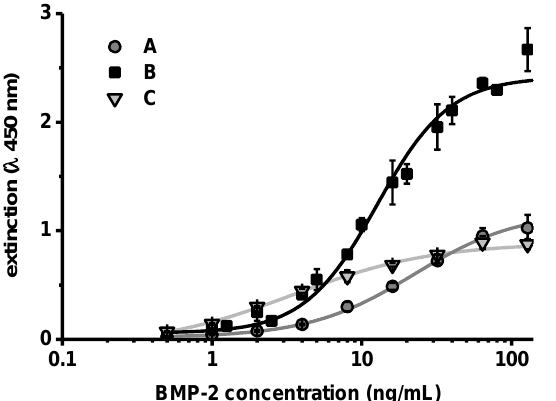
Figure 8. Extinction values obtained after BMP-2 ELISA of concentration series in ( A ) PTB, ( B ) PTB